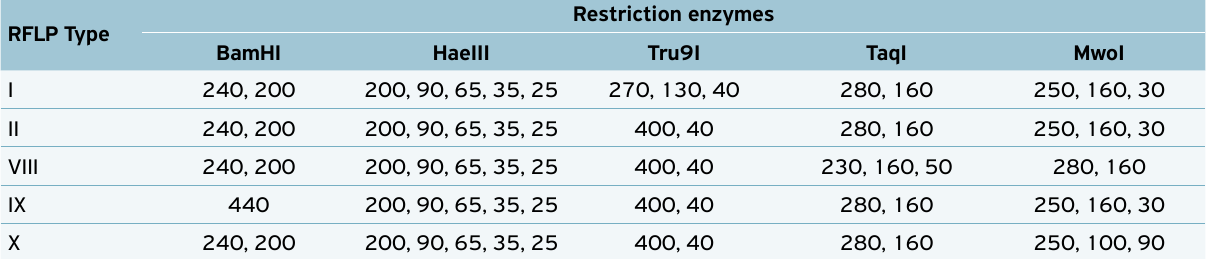
Table 2. Products generated by restriction enzyme cleavage of the 440 bp fragment of the bovine leukemia virus env gene RFLP